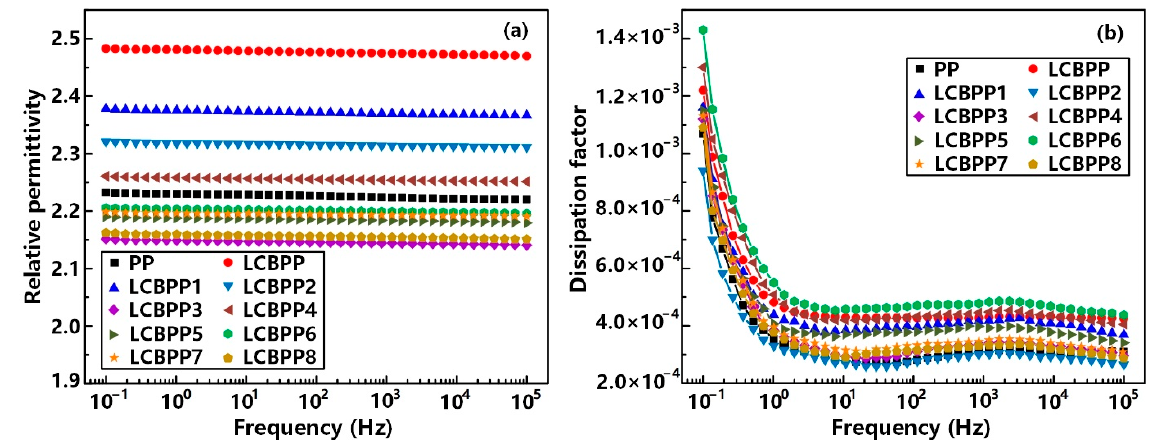
Figure 8. Relation between ( a ) the relative permittivity, ( b ) the dissipation factor and the fre-